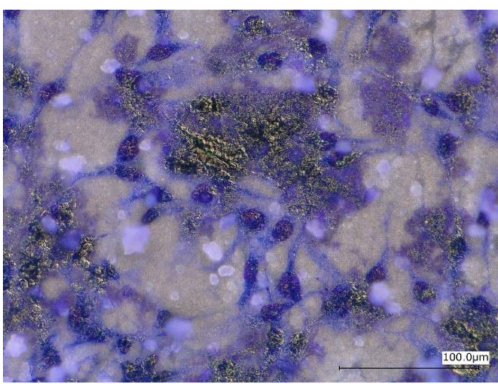
Figure 14. Morphology of the HAp-coated Mg-10ZnO-2.5 h + 10 min sample after 72 h of cell